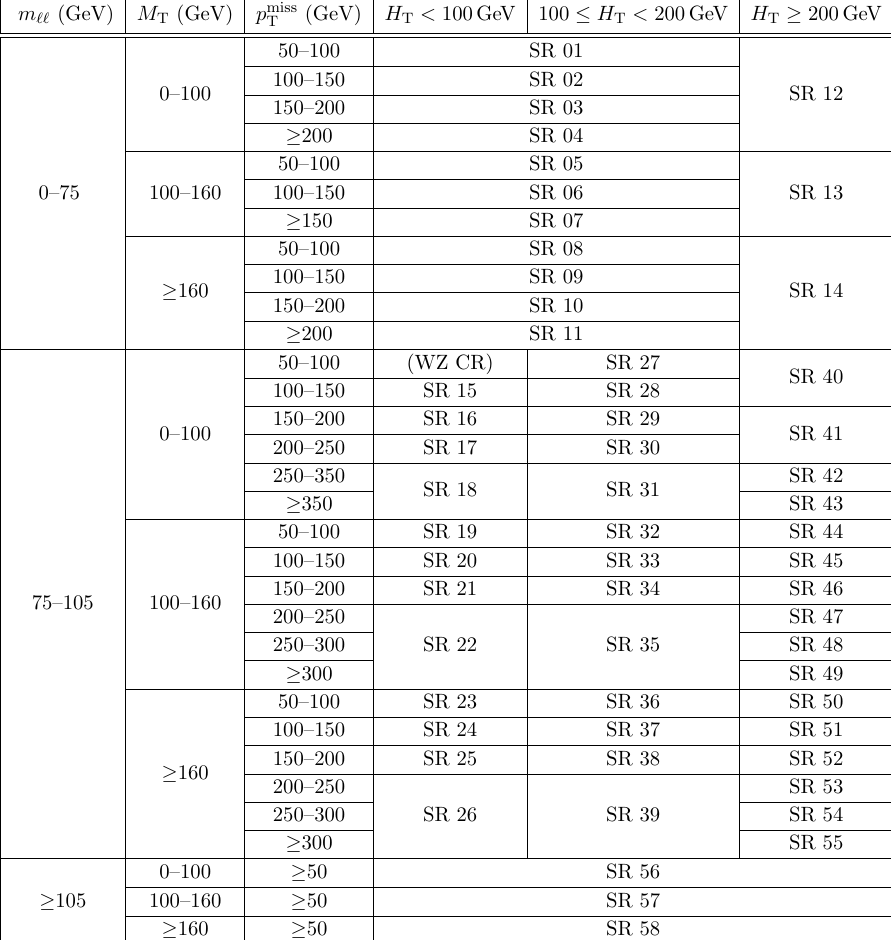
Table 2 . De(cid:12)nition of the search regions (SRs) optimized for the WZ corridor in the WZ signal topology. Events must have three leptons (e, (cid:22) ) forming at least one OSSF pair and they are categorized in m ‘‘ , M T , p miss